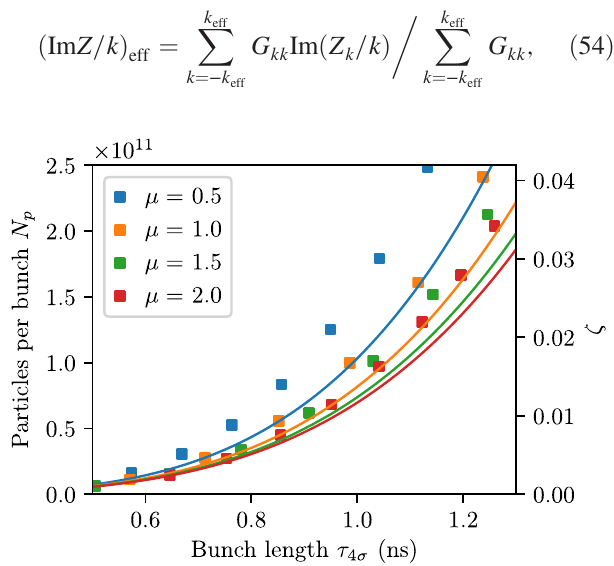
FIG. 5. The LLD intensity threshold as a function of the bunch length for the binomial particle distribution with different values of μ calculated using MELODY (squares) and Eq. (50) (lines) for η > 0 , V 6 MV and inductive impedance Im Z=k ¼ 0 . 07 Ω 0 ¼ 4 GHz. The corresponding intensity parameter ζ is with f c ¼ shown on the second vertical